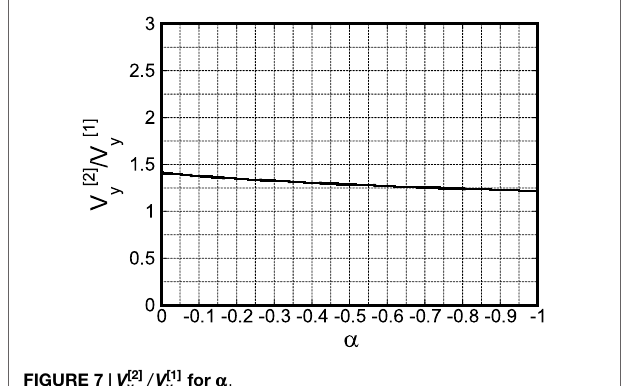
FIGURE 7 | V [2] y = V [1] y for ααα .